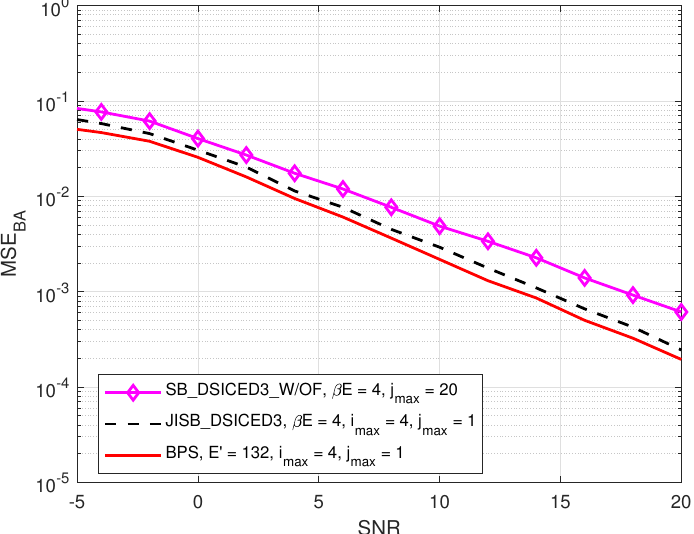
Figure 6. MSE BA versus SNR, p B / σ 2 w ; R = 1/2, i max = 4, j max = 20, p SI / σ 2 w = 30 dB, β E = 4 symbols, and E = 128